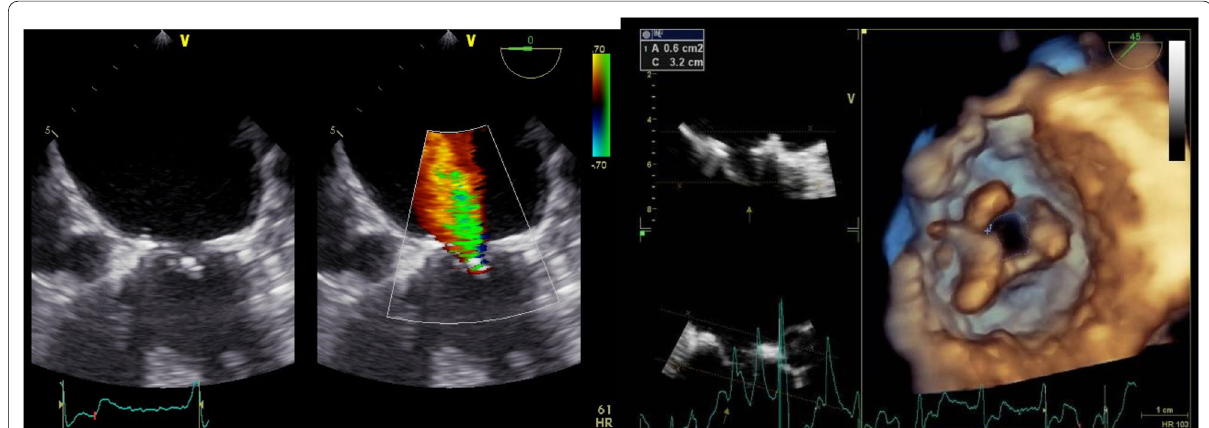
Fig. 1 preoperative TEE showed comined severe mitral stenosis (MVA 0.6 cm 2 ) and moderate valvular mitral regurge. TEE: transesophageal echokardiography, MVA: mitral valve area